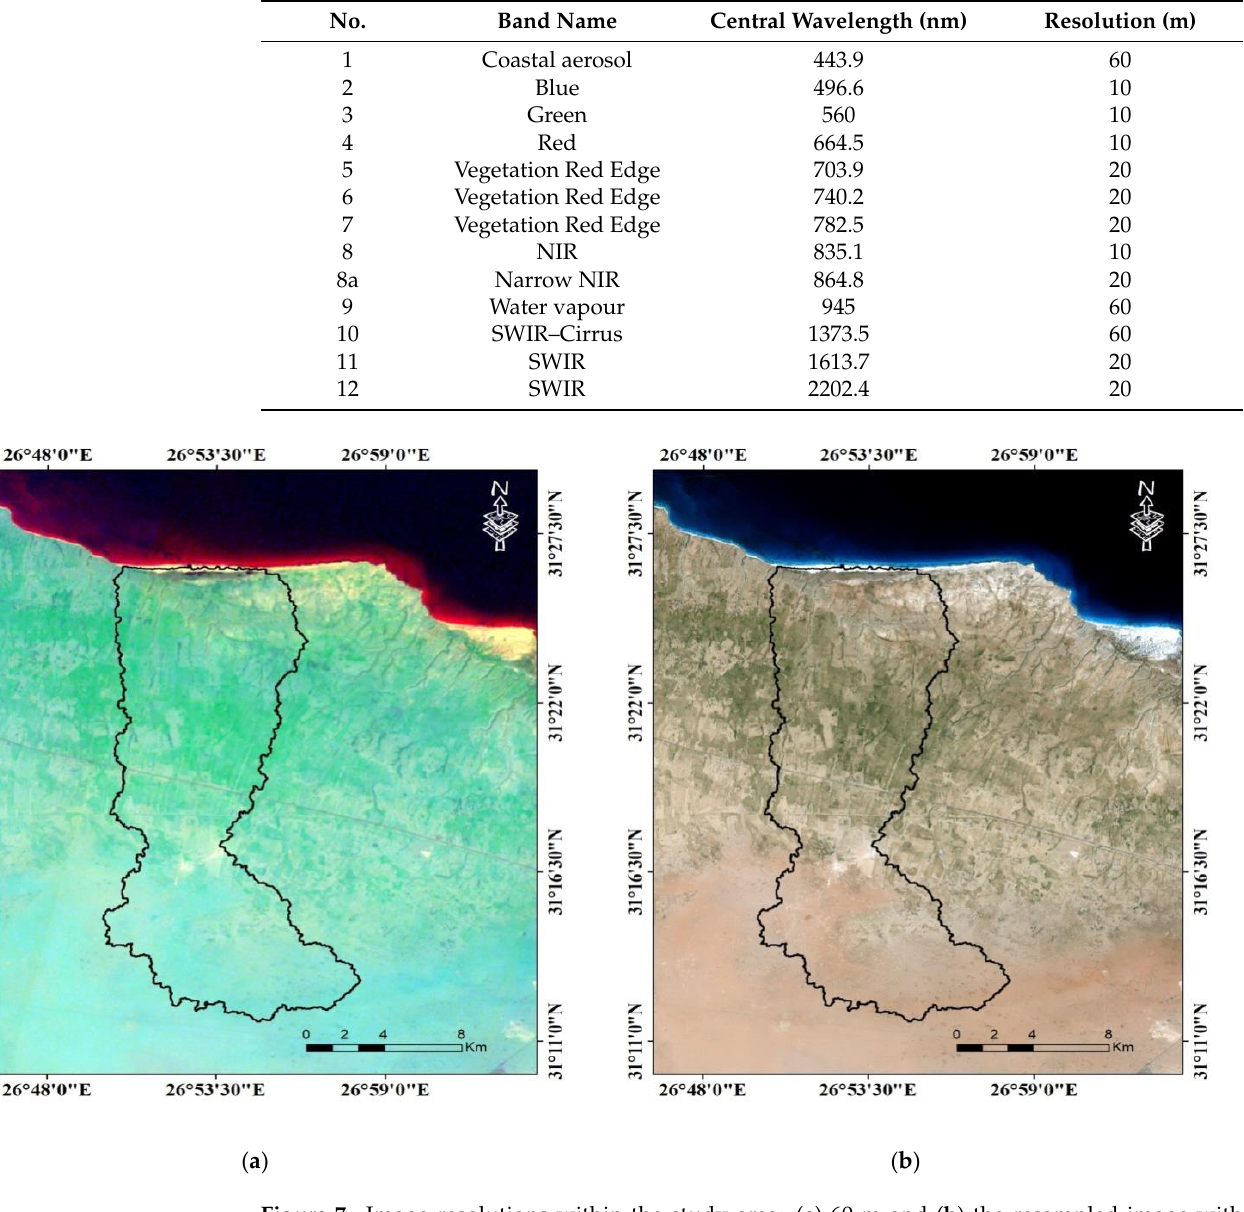
Figure 7. Image resolutions within the study area: ( a ) 60 m and ( b ) the resampled image with 10 m resolution. Table 1. Characteristics of the Sentenial2 satellite image.